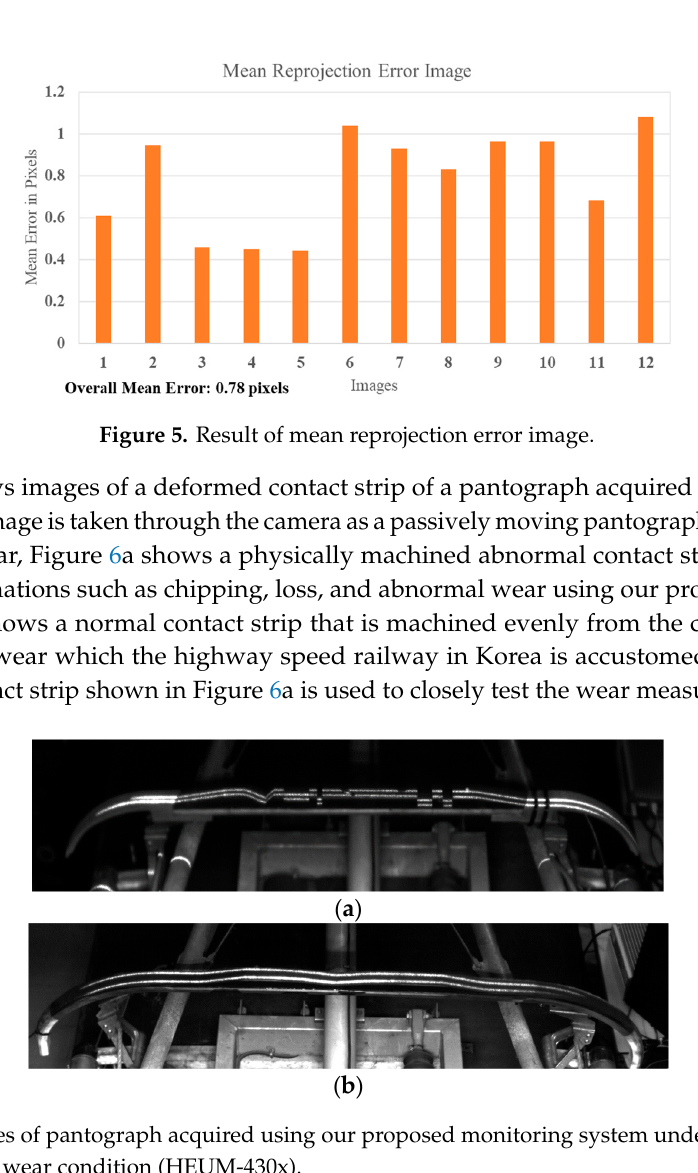
Figure 6. Images of pantograph acquired using our proposed monitoring system under ( a ) abnormal and ( b ) normal wear condition (HEUM-430x).